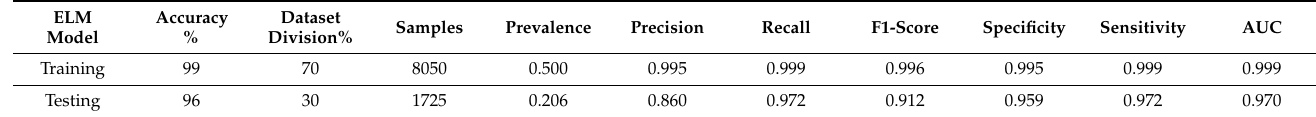
Table 5. ELM Performance Parameters for Experiment # 2.